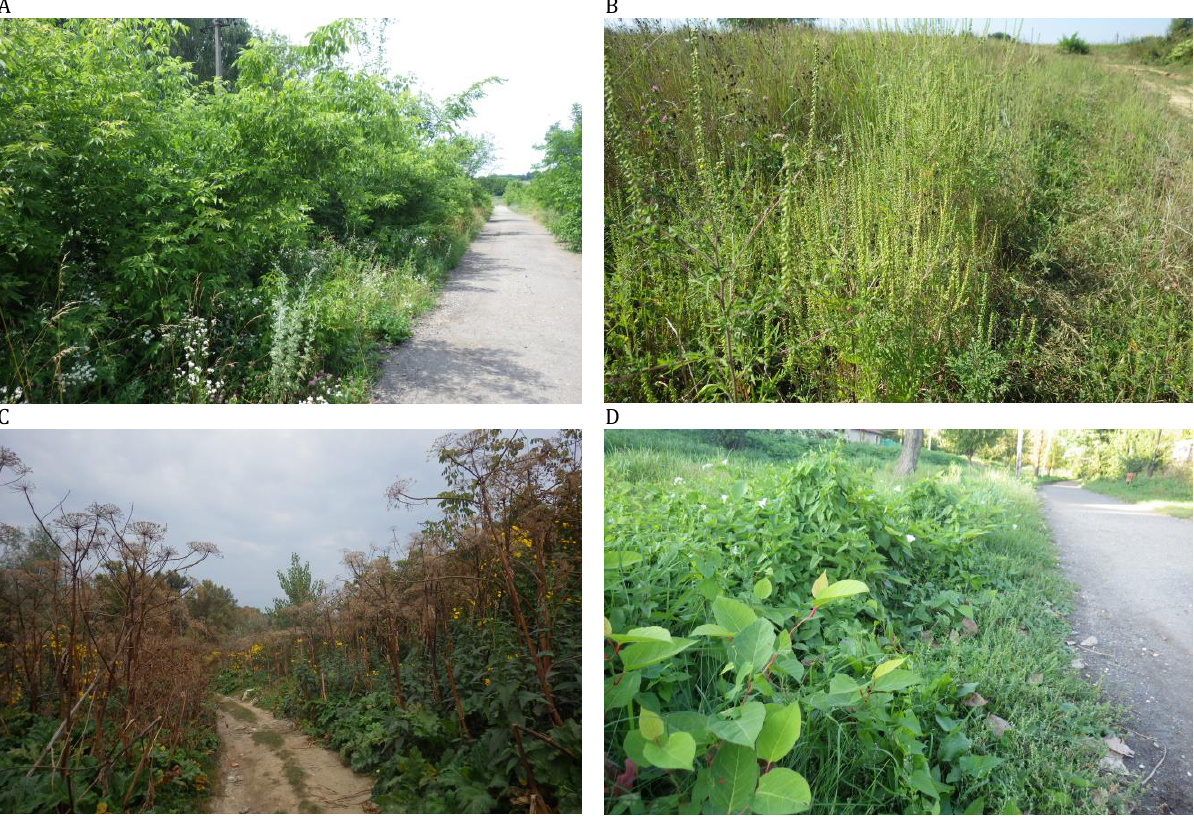
Fig. 7. Transformer species in the ruderal plant communities of Ukraine: A – Acer negundo in the “Seimskyi” Regional Landscape Park (Sumy Region), B – Ambrosia artemisiifolia near Rakoshyno village (Transcarpathian Region), C – Heracleum sosnowskyi and Helianthus tuberosus in Uzhgorod (Transcarpathian Region), D – Reynoutria japonica in Beregovo (Transcarpathian Region) (photo by M.